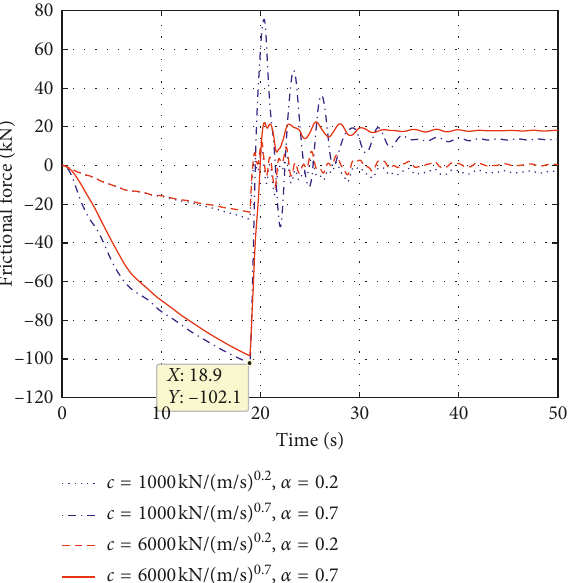
Figure 18: Frictional force of the movable support.